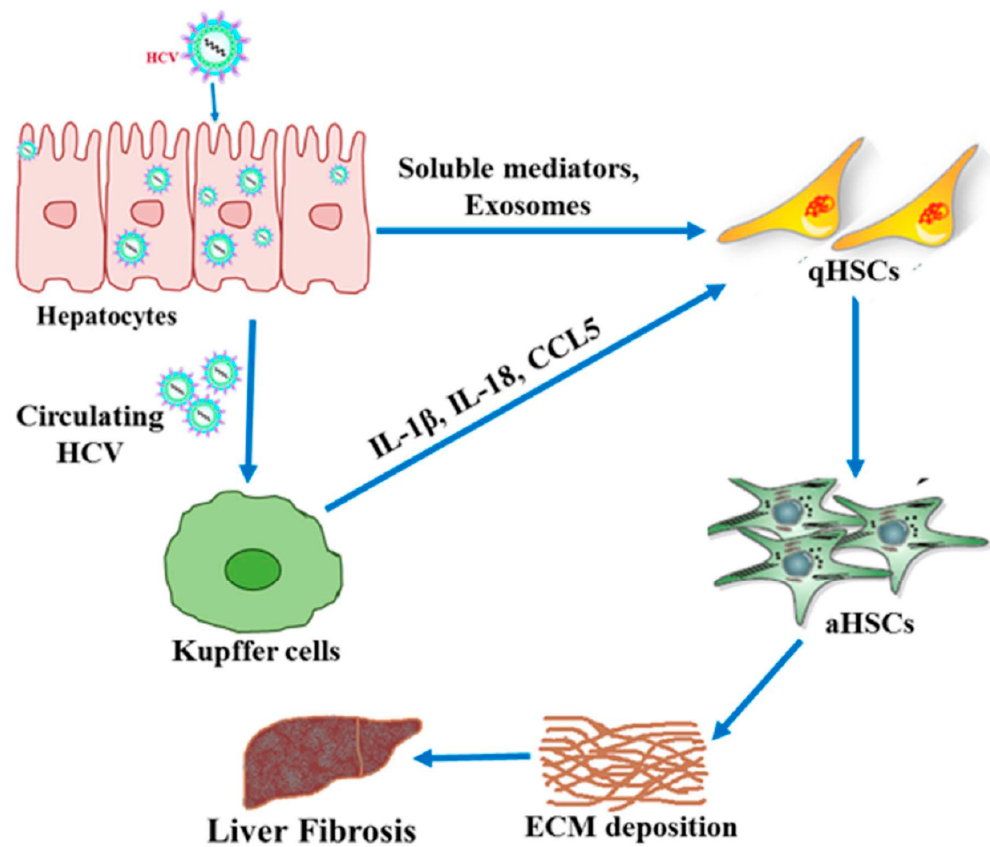
Figure 2. Communication among HCV-infected hepatocytes, quiescent HSCs (qHSCs) and Kupffer cells. HCV-infected hepatocytes secrete soluble mediators (cytokines/chemokines) and exosomes, and interact with qHSCs. On the other hand, circulating HCV released from infected hepatocytes interact with Kupffer cells and promote secretion of proinflammatory cytokines/chemokines, including IL-1 β , IL-18 and CCL5. These mediators help quiescent hepatic stellate cells (qHSCs) activate HSCs (aHSCs), enhancing the deposition of the extracellular matrix (ECM) into the liver for fibrosis.